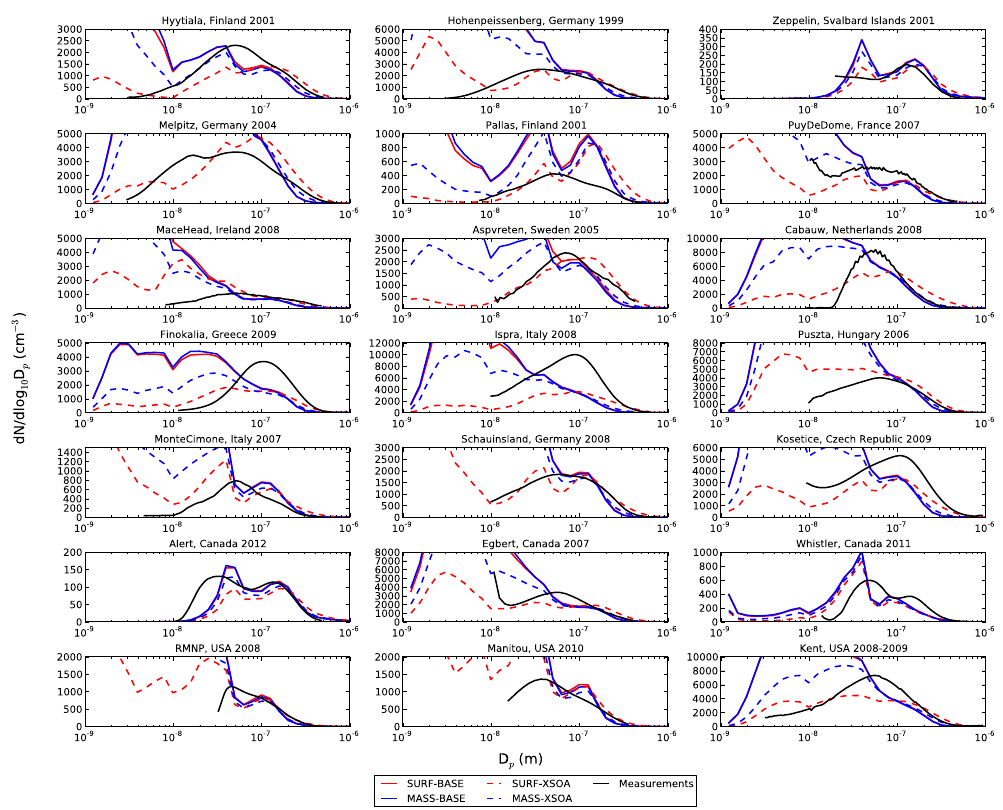
Figure 8. Observed and simulated annual- and campaign-mean particle number size distributions for the global sites outlined in Table 2. The simulations with sub-20 nm growth rate parameterizations (SURF-XSOA-K and SURF-XSOA-H) had small changes from the SURF-XSOA case and were thus withheld from this figure.